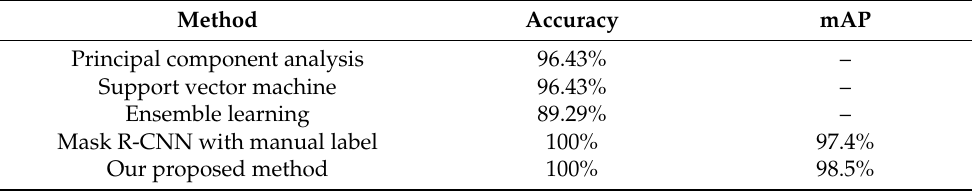
Table 2. Comparison of recognition accuracy and target detection results of different